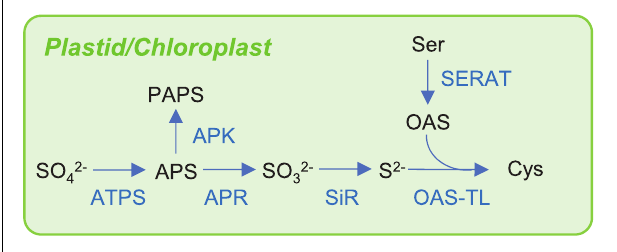
FIGURE 2 | Sulfur assimilation pathway in plant. Abbreviations are summarized in Table 1 .